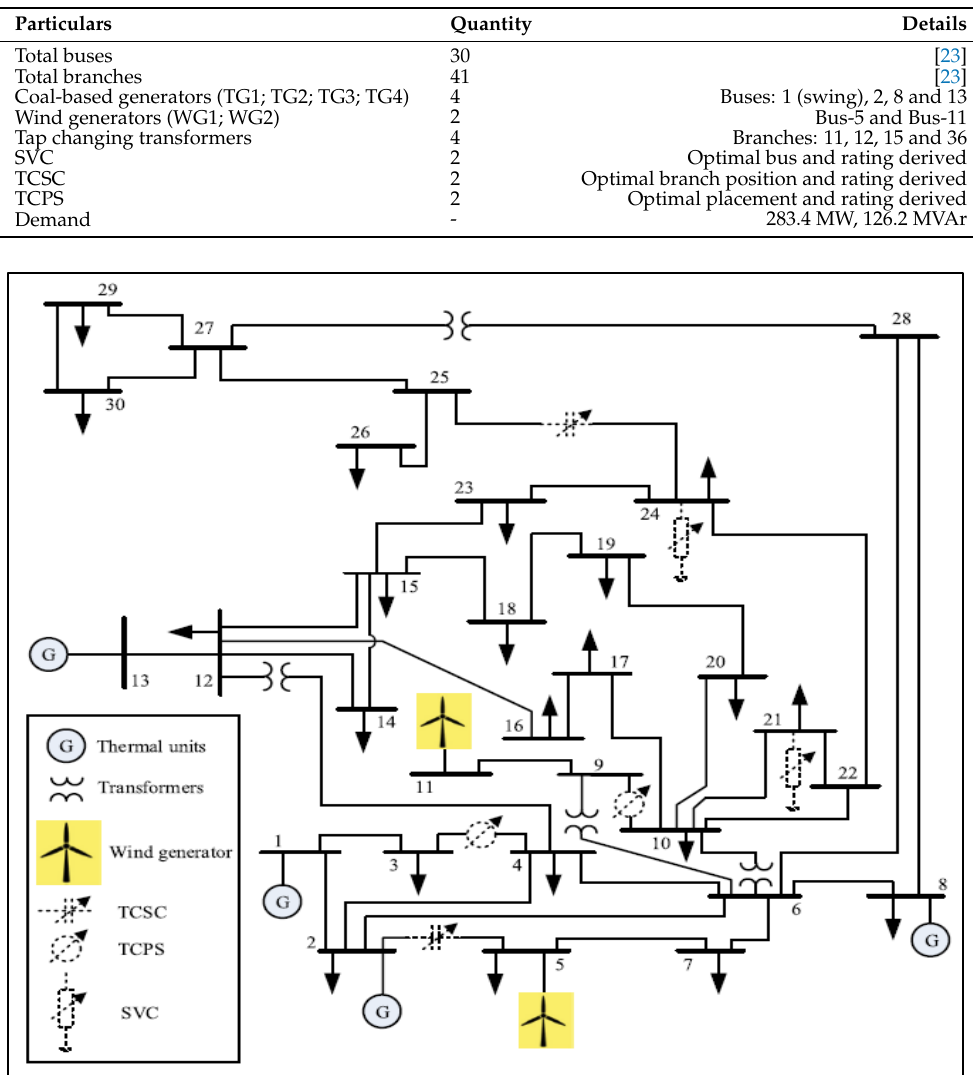
Table 1. Test system key features for analysis.